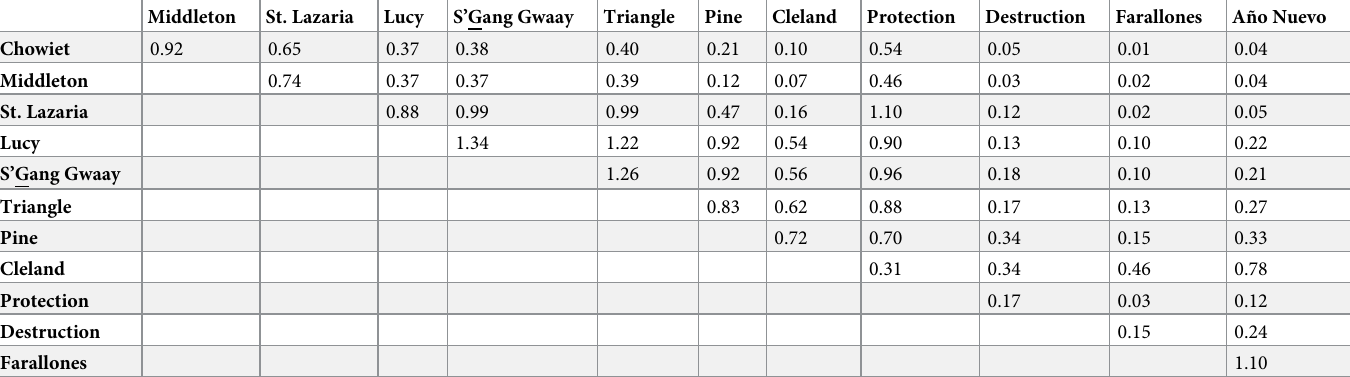
Table 6. Spatial overlap between home ranges of during wintering months (Nov-Feb) of rhinoceros auklets breeding at 13 colonies on the Pacific Coast of North America, 2014 to 2016, as calculated from the Utilization Distribution (UD) derived from geolocation of light loggers.